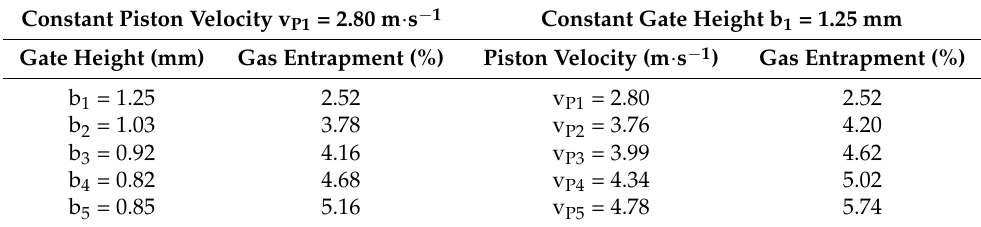
Table 3. Gas entrapment in the cast volume.